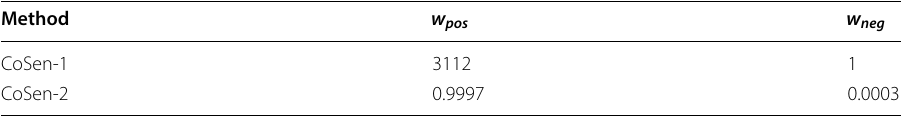
Table 8 Cost-sensitive learning